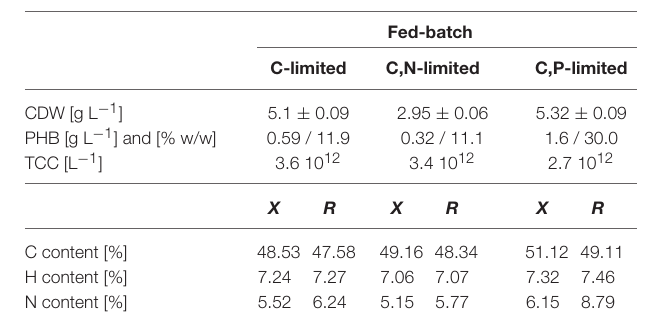
TABLE 1 | Concentration and composition of dried R. rubrum biomass at the end of the (multiple) nutrient-limited